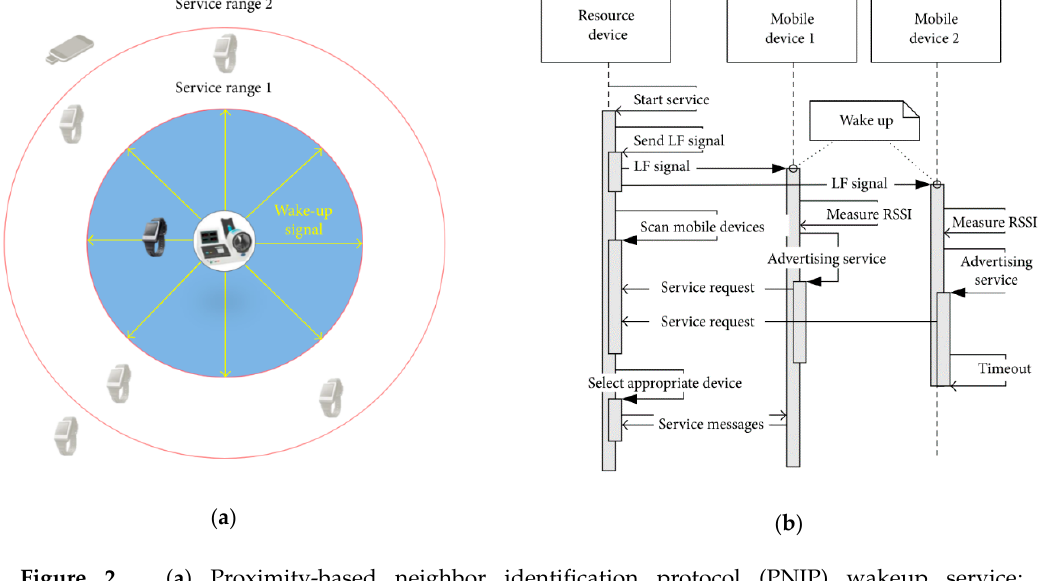
Figure 2. ( a ) Proximity-based neighbor identification protocol (PNIP) wakeup service; ( b ) Sequence